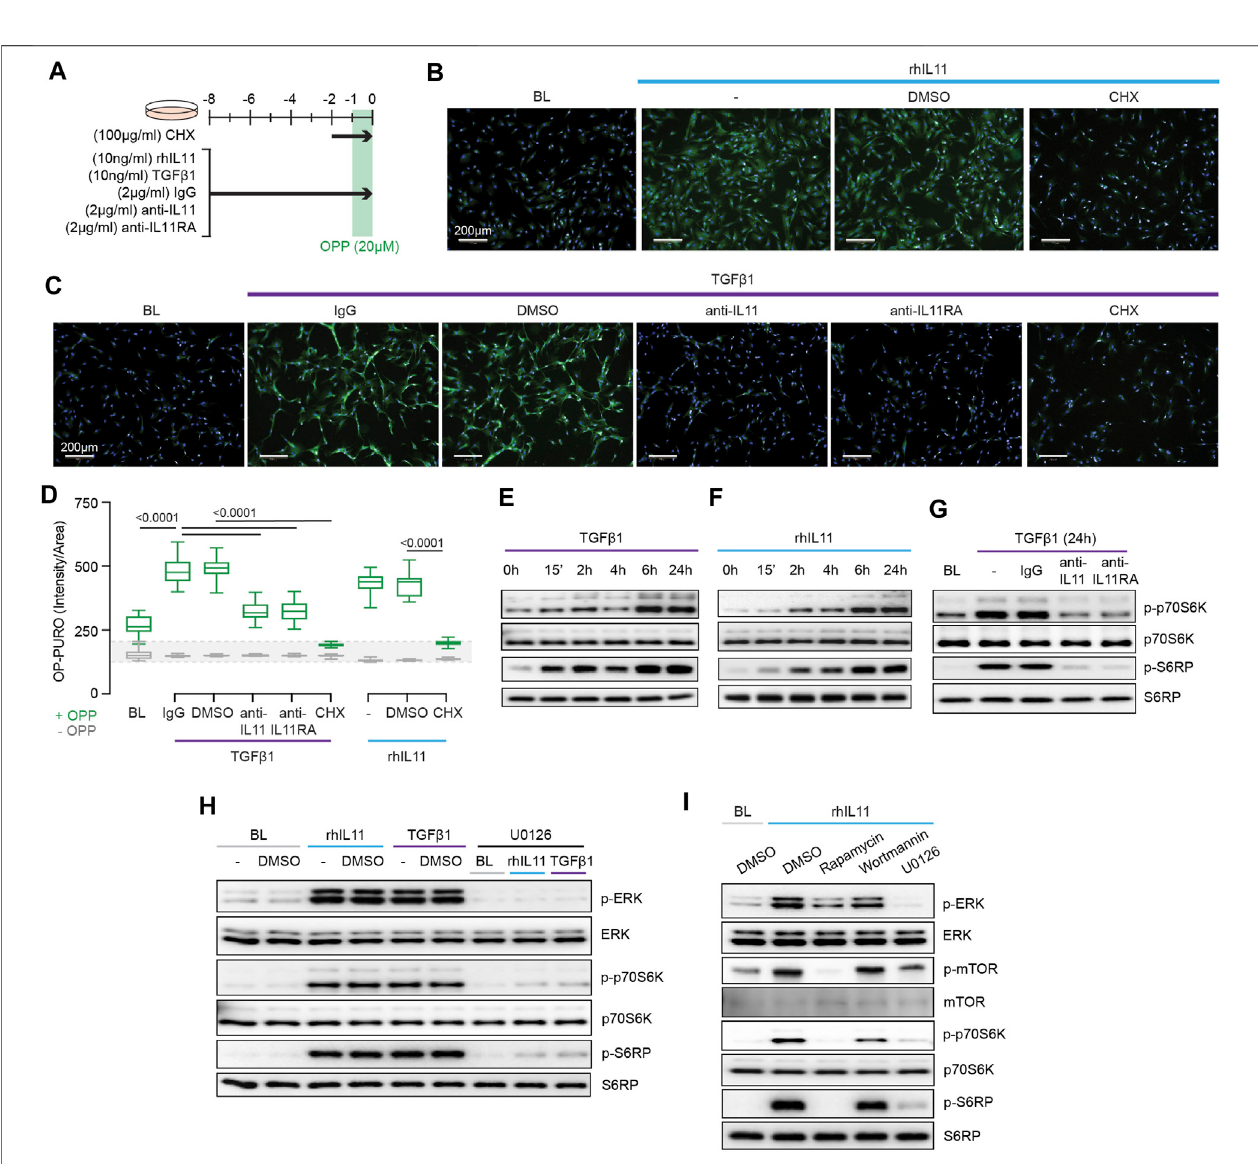
FIGURE 3 | TGF β 1-and IL11-stimulated protein synthesis is ERK- and mTOR-dependent. (A) Schematic for experiments shown in (B – D) . (B – D) (B,C) Immuno fl uorescence images (scale bars, 100 μ m; n (cid:2) 3) and (D) quanti fi cation of Alexa Fluor ™ 488 - OPP signal in HCFs ( n (cid:2) 14) following treatments shown in (A) . (E – G) Western blots of p-p70S6K (T389), p70S6K, p-S6RP, S6RP from (E) TGF β 1 or (F) rhIL11-stimulated HCFs over a time course and on (G) IgG, anti-IL11, or anti- IL11RA-treated TGF β 1-stimulated HCFs ( n (cid:2) 1). (H) Effects of U0126 on TGF β 1 or rhIL11-induced ERK, p70S6K (T389), and S6RP activation ( n (cid:2) 1). (I) Comparison effects of Rapamycin, Wortmannin, and U0126 on rhIL11-induced ERK, mTOR, p70S6K, and S6RP activation ( n (cid:2) 1). (B – I) primary HCFs; IL11/TGF β 1 (10 ng/ml), OPP (20 µM), CHX (100 μ g/ml), IgG/anti-IL11/anti-IL11RA (2 μ g/ml), U0126 (10 µM), Rapamycin (10 nM), Wortmannin (1 µM); (B – D) 8 h, (G – I) 24 h. (D) Data are shown as box-and-whisker with median (middle line), 25th – 75th percentiles (box) and min-max percentiles (whiskers); one-way ANOVA with Tukey ’ s correction. IL11 stimulates translation of proline-rich pro- fi brotic genes via EPRS.